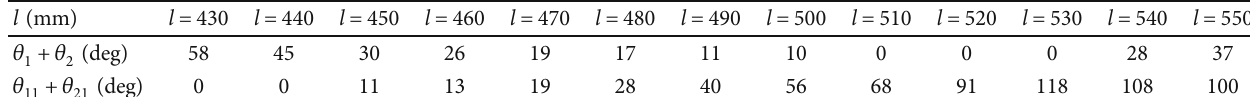
Table 1: The lengths of Bowden cable and corresponding curve angles.